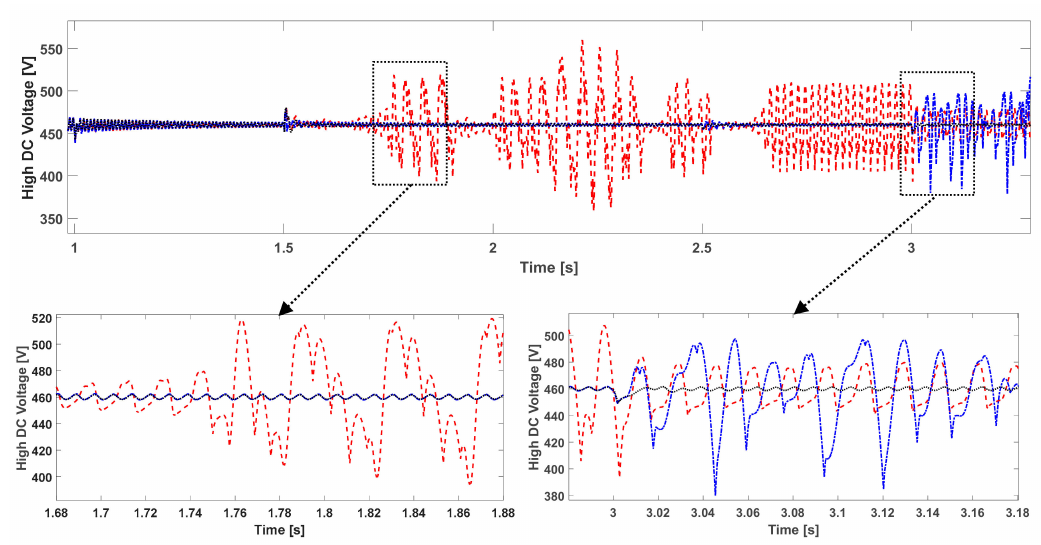
Figure 23. High-DC voltage during faulty operation (80% power-loss